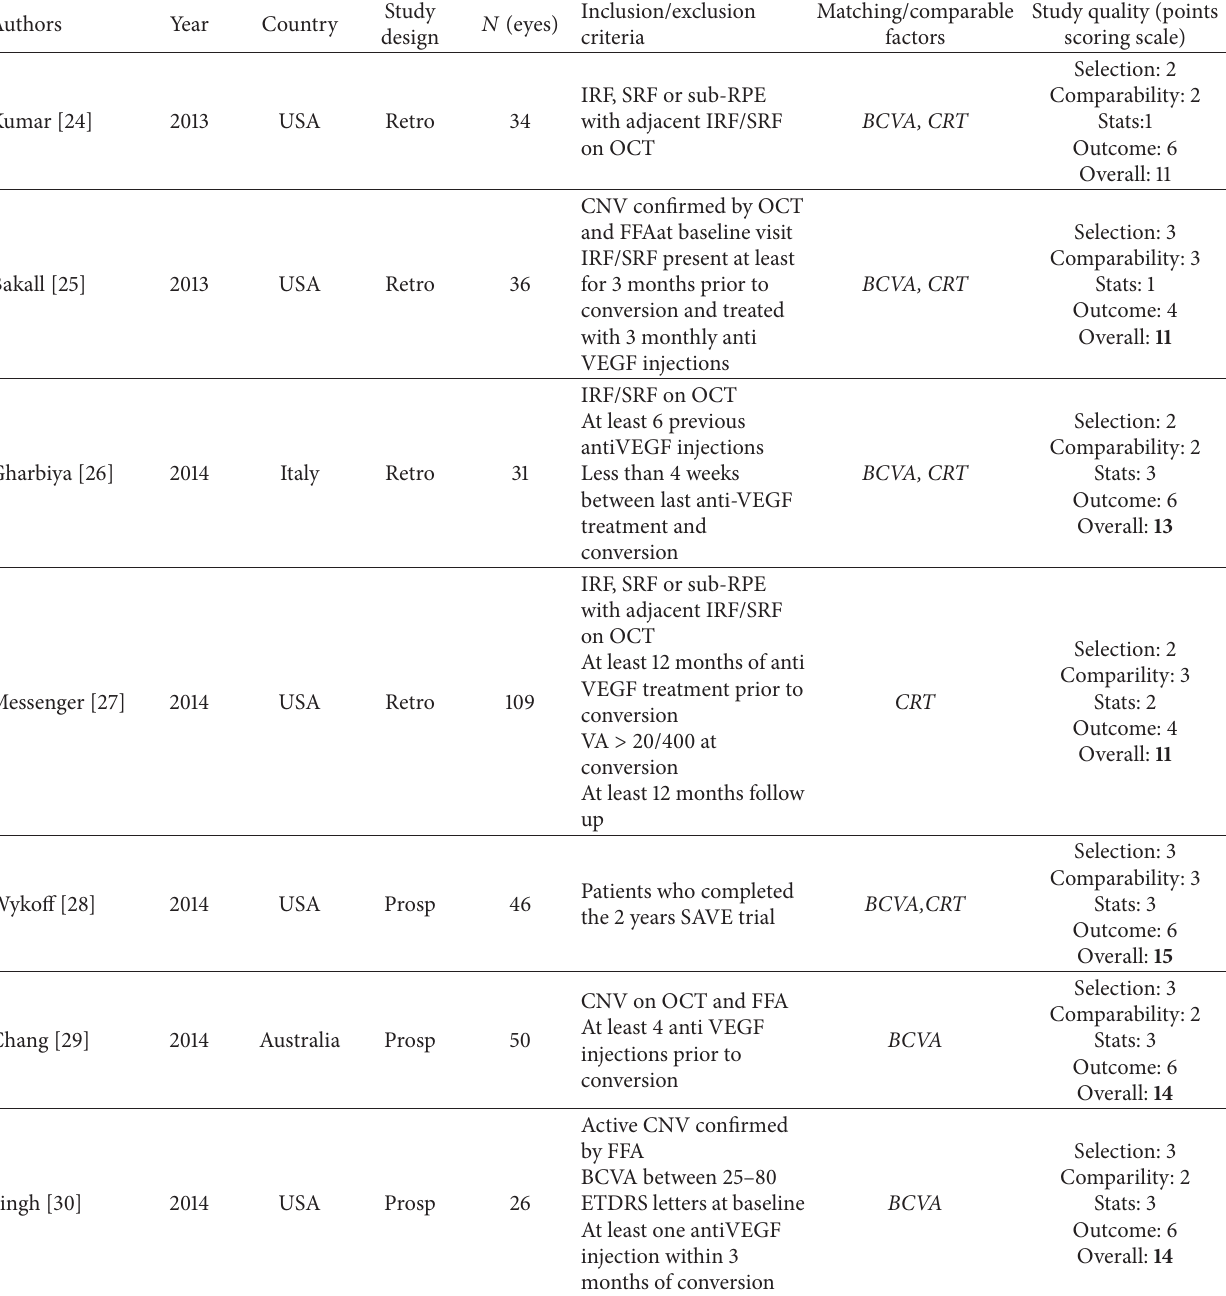
Table 1: Characteristics of all studies included in the Meta